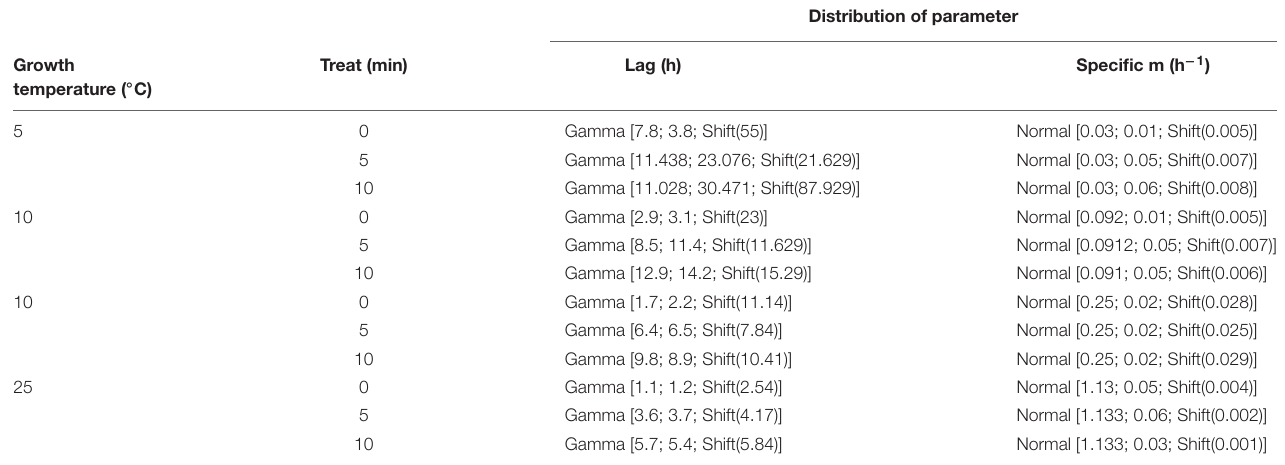
FIGURE 2 | Probability of growth (Pg) of C. sakazakii as a function of exposure time at 50 ◦ C by 0, 5, and 10 min and growth temperatures of 5, 10, 15, and 25 ◦ C. The continuous black lines, for which equations are shown in the figure, show the relationships found in our experiments. TABLE 3 | Incubation temperature, duration of heat treatments, fitted distribution and parameters used to simulate growth of untreated and heat treated cells of a single cell of C. sakazakii. Distribution of